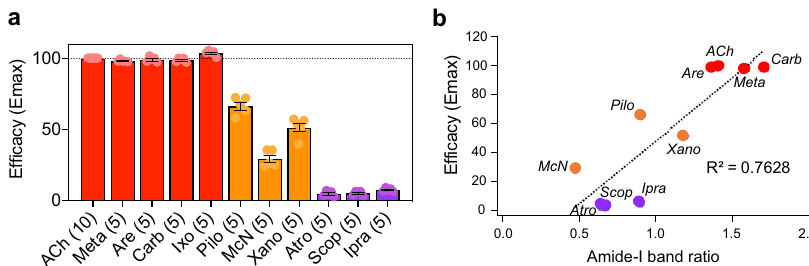
Fig. 3 Correlation between ligand ef fi cacy and amide-I band ratio. a Ef fi cacies of the different M 2 R ligands toward G i activation in the NanoBiT G-protein dissociation assay. E max values were calculated from the concentration-response sigmoidal curves in Extended Data Fig. 6 and were normalized to that of ACh performed in parallel. Bars and error bars represent mean and SEM, respectively, of 5 or 10 (shown in parenthesis) independent experiments with each performed in duplicate. b Correlation between ligand ef fi cacy and the relative intensities of the amide-I bands. The relative intensities of the amide-I bands are calculated by the equation of ef fi cacy rate, which is derived from Fig. 2c. Ligand ef fi cacy is determined by the NanoBiT G-protein dissociation assay from a . Agonists (ACh, Meta, Are, and Carb) are shown as red circles, partial agonists (Pilo, McN, and Xano) as orange circles, and antagonists (Atro, Scop, and Ipra) as purple